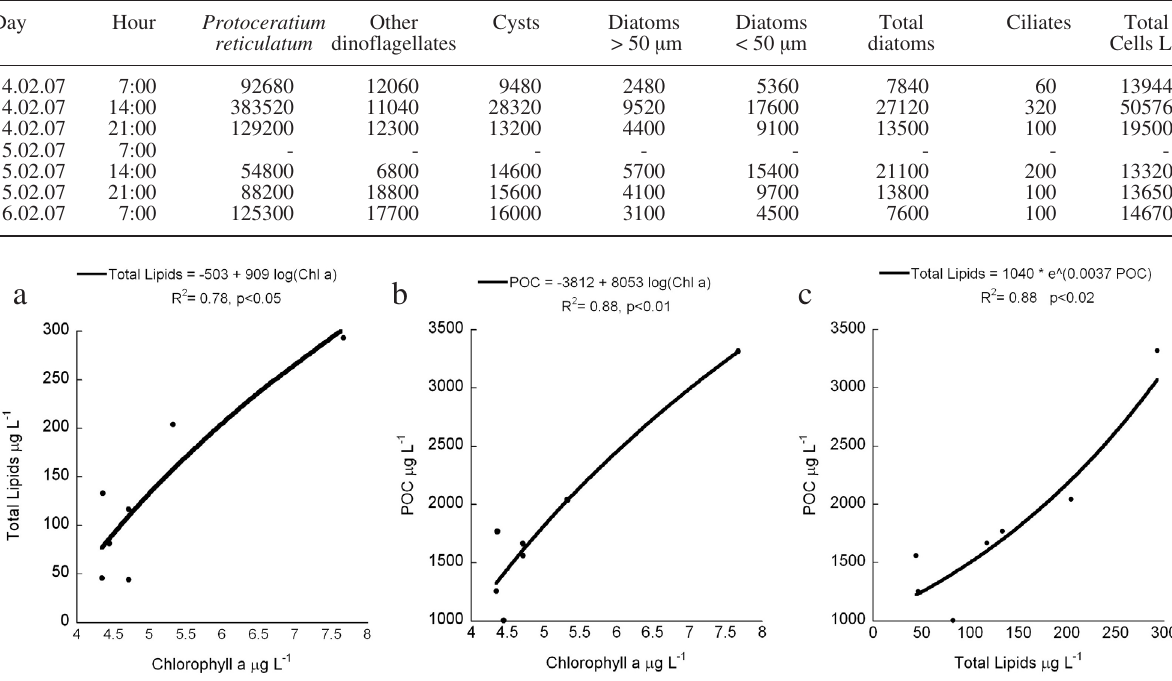
Table 2. – Main groups of phytoplankton in Chipana Bay during the short time cycle of 14-16 February 2007. For 15 February no sample is available. Diatoms above 50 µm include diatom chains found in the present study.